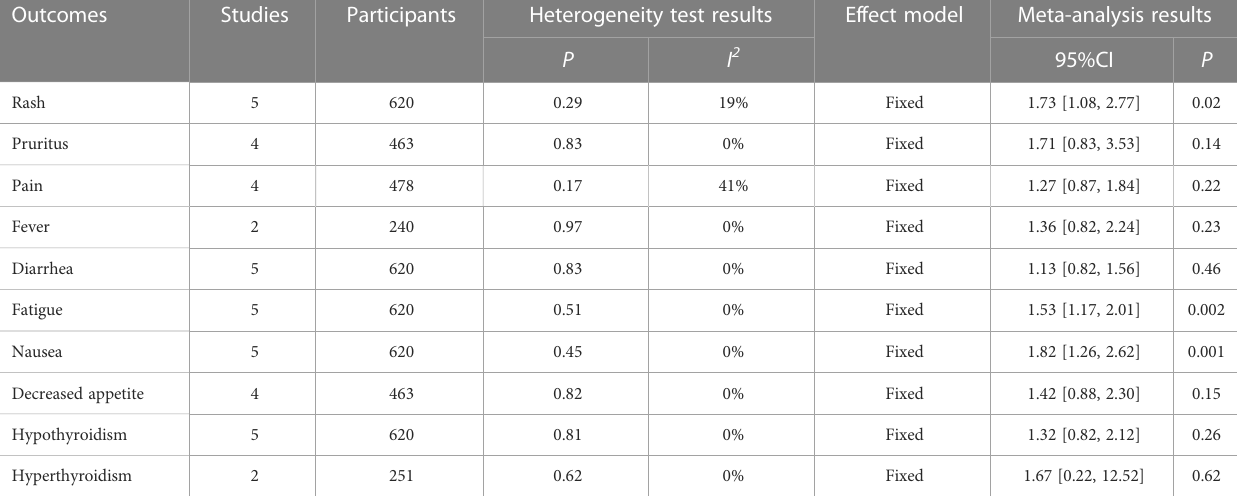
TABLE 4 Meta-analysis results of Treatment-related AEs.